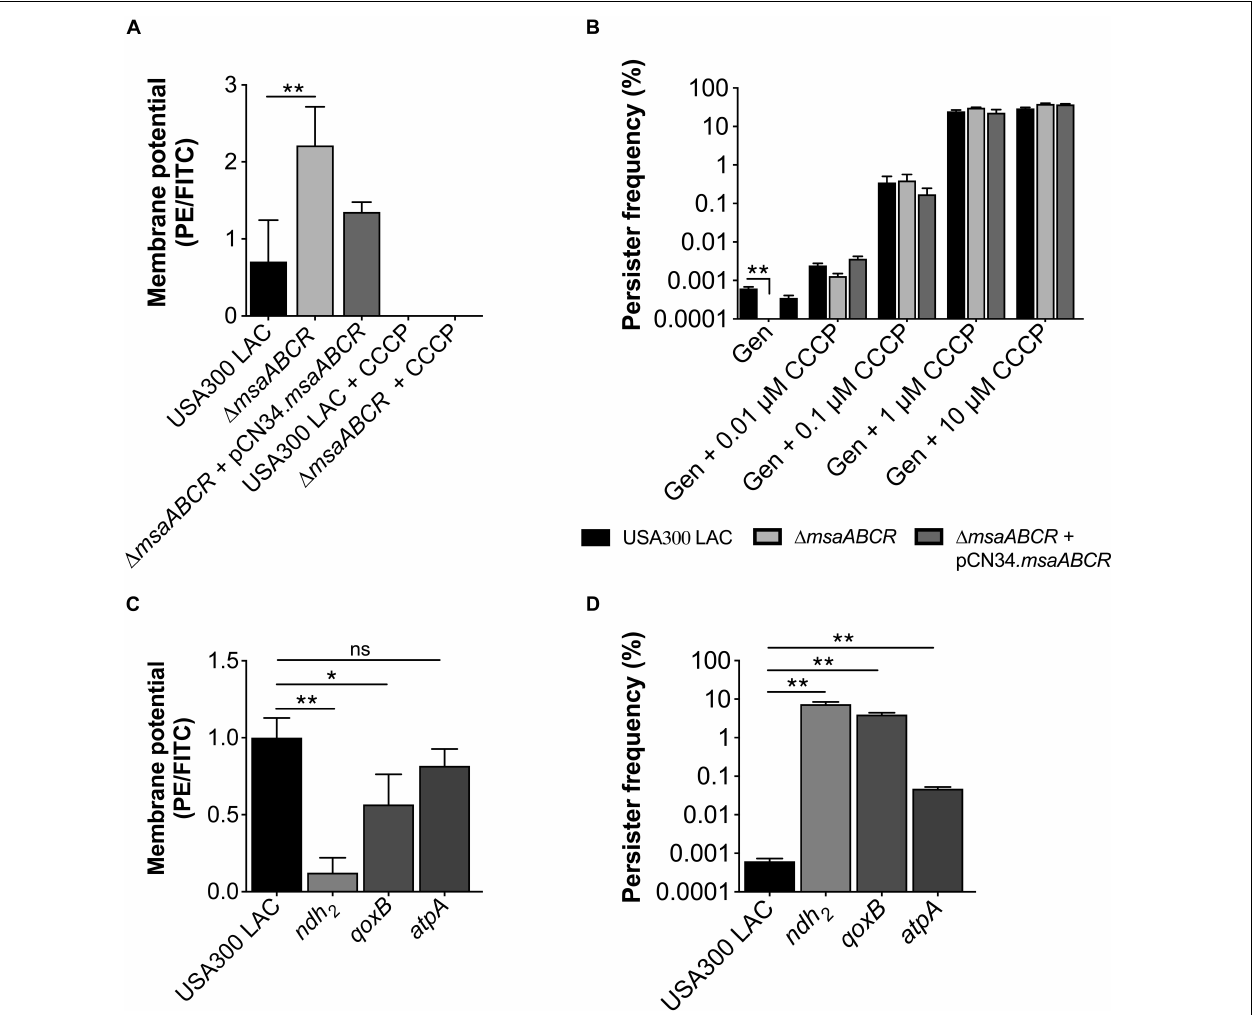
FIGURE 7 | Measurements of membrane potential and persister frequency. (A) Stationary-phase cells washed twice with PBS were incubated with 3, 3 (cid:48) -diethyloxacarbocyanine iodide (DiOC 2 (3)) for 30 min in room temperature. After incubation, the cells were subjected to flow cytometry. The data represents the ratio between channel F3 (red fluorescence) and F1 (green fluorescence), calculated with FlowJo software. (B) Stationary-phase cells pre-incubated for 30 min with different concentrations of carbonyl cyanide m-chlorophenyl hydrazone (CCCP) were exposed to gentamicin (20 µ g/ml). At 24 h post exposure, the cells were harvested, washed, and plated for CFU counting. (C) Measurement of membrane potential. (D) Measurement of persister fraction in the mutants of the ETC genes ndh2 , qoxB , and atpA compared with the isogenic USA300 LAC strain in the presence of gentamicin (20 µ g/ml). Data represents the log 10 survival fraction for the average of three independent experiments. Error bars represent SEM. Statistical significance was determined using ANOVA followed by Tukey’s multiple comparison tests. *, P < 0.05; **, P <